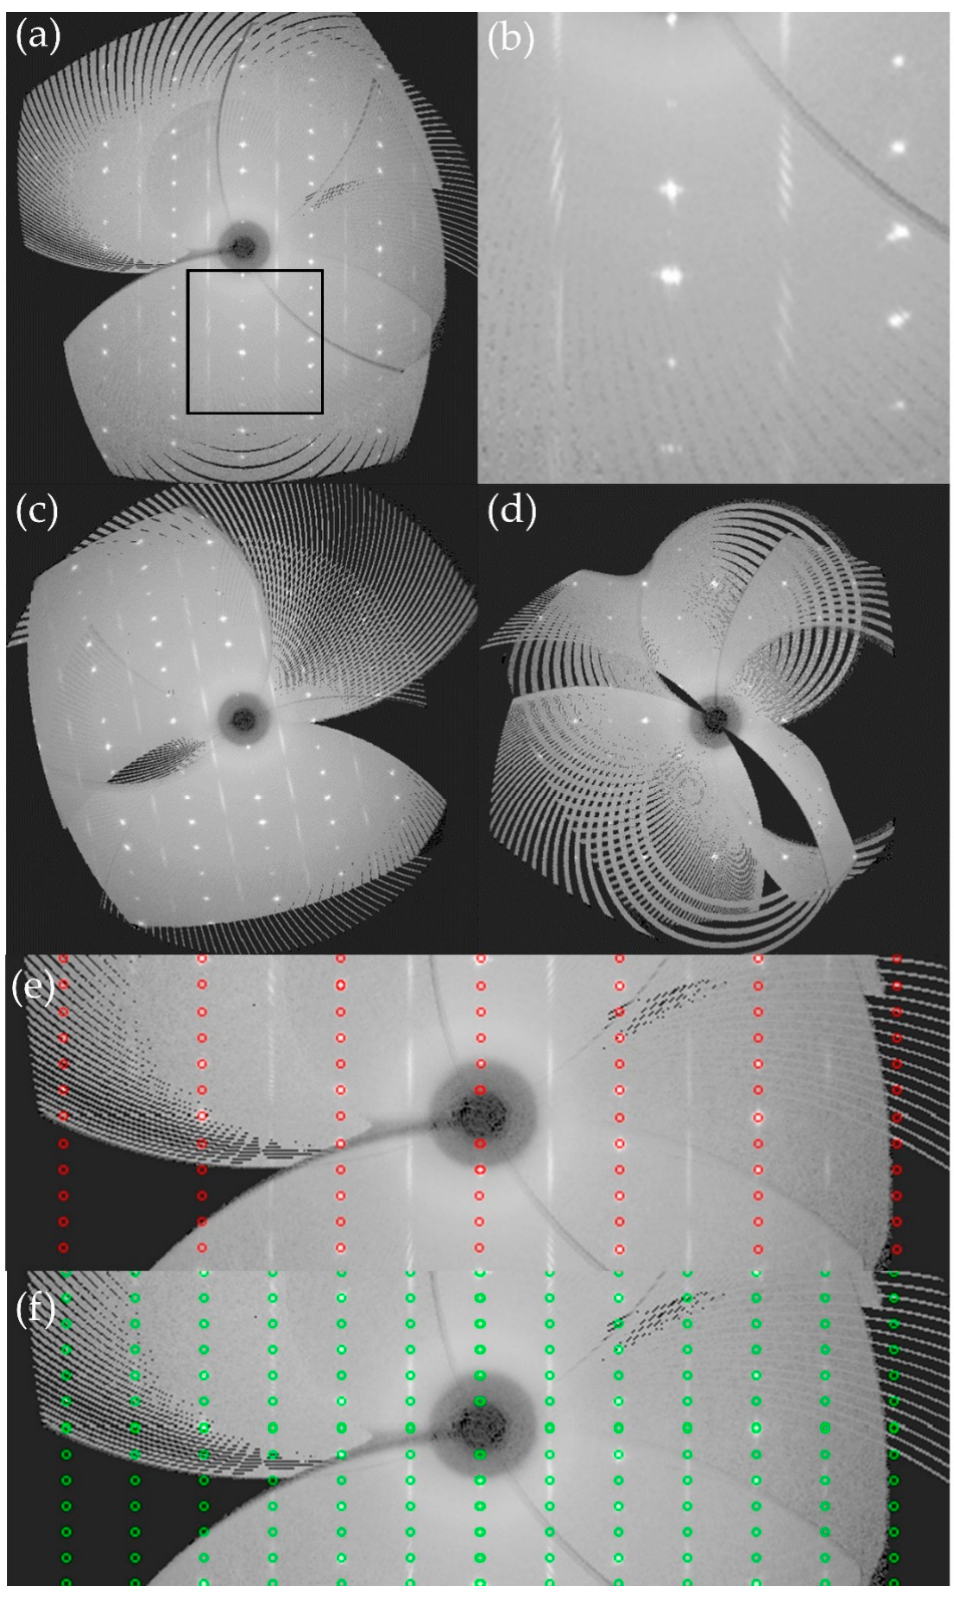
Figure 1. Reconstructed diffraction pattern of SrLi 2 {Li 0.65 Co 0.35 [Co 0.65 Li 0.35 N 2 ]} ( a ) 0 kl ; ( b ) Magnified section from marked region in Figure 1a; ( c ) h 0 l ; ( d ) hk 0; ( e ) 0 kl with superimposed reflections for a tetragonal lattice (red); ( f ) 0 kl with superimposed reflections for a monoclinic lattice (green).